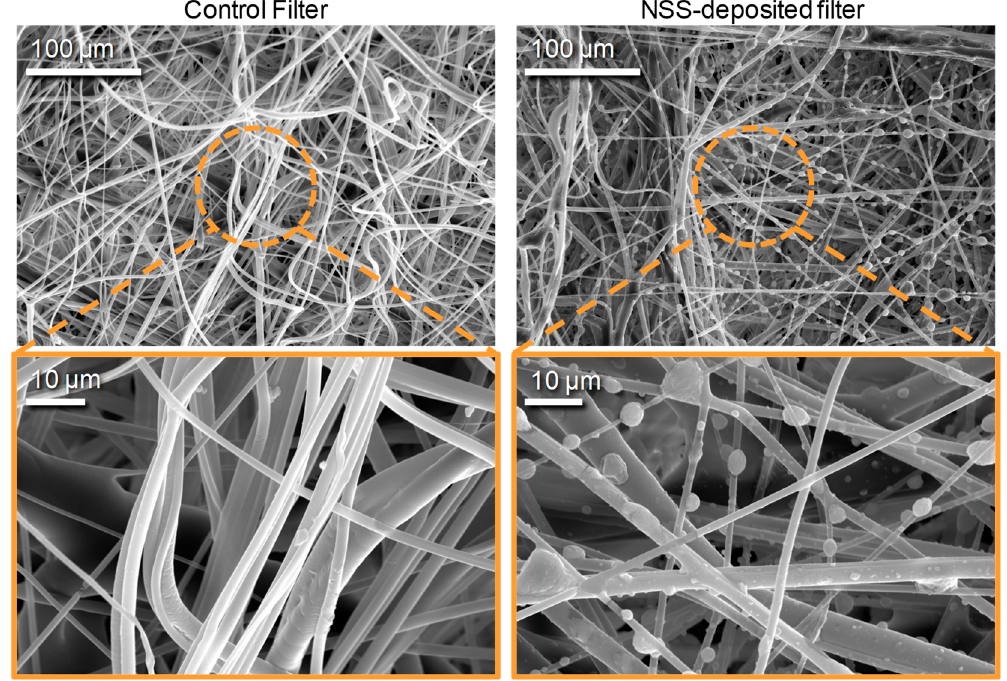
Figure 4. SEM images of the control filters (left ) and NSS-deposited filters ( right ).